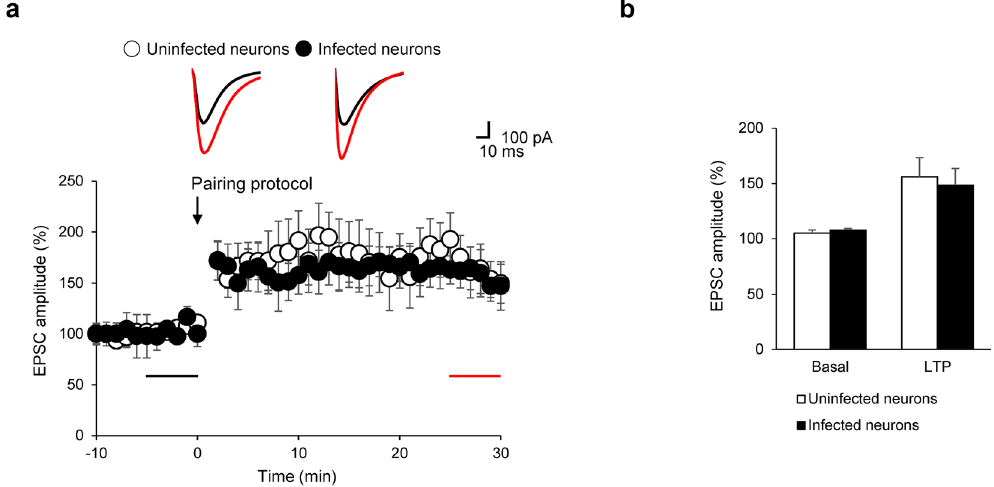
Figure 5. Induction and expression of pairing protocol-induced LTP were not affected by rapamycin or acute reduction of PIP 2 . ( a ) Normalized EPSC amplitudes before and after LTP induction. Amplitudes of EPSCs are normalized to baseline levels that were recorded for 10 min before the pairing protocol (arrow). Rapamycin treatment occurred prior to the beginning of the recording. Inserts: representative traces of evoked EPSCs with color- matched time points ( b ) Mean EPSC amplitudes before and after LTP induction in CA1 neurons for each group. (Basal: uninfected 105.09 ± 2.76%, N = 5, n = 5 vs . infected 107.83 ± 1.31%, N = 4, n = 4, p > 0.1, LTP: uninfected 156.16 ± 17.48%, N = 5, n = 5 vs . infected 148.60 ± 14.98%, N = 4, n = 4, p > 0.1, Mann-Whitney U-test). Error bars show mean ±